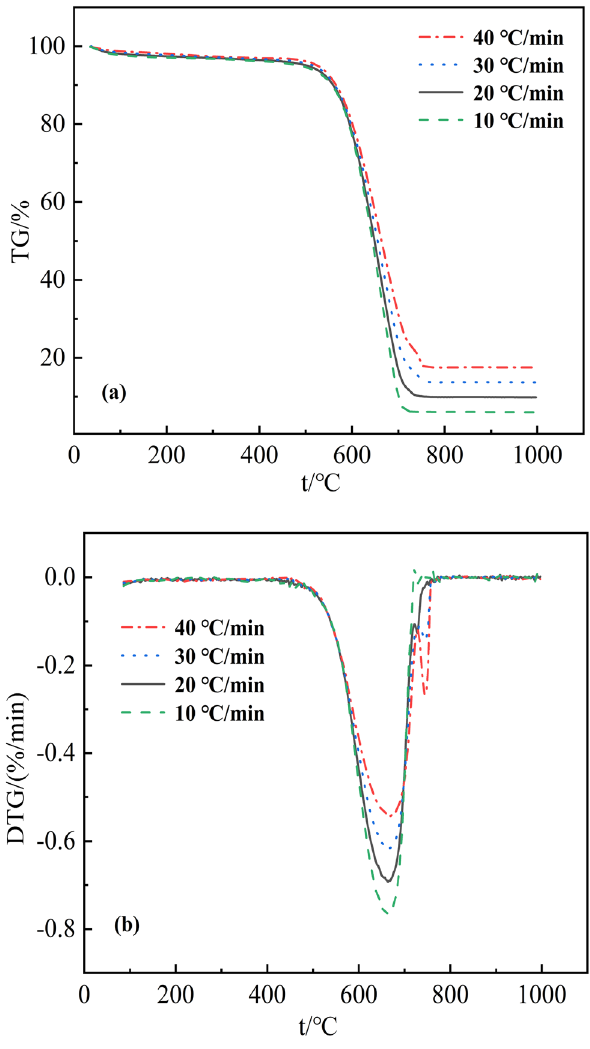
Figure 2: TG – DTG curves of K1 sample at di ff erent heating rates: ( a ) TG and ( b ) DTG